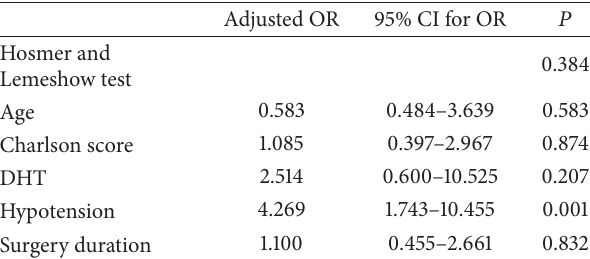
Table 5: Multivariate logistic regression with “hospital stay” as dependent